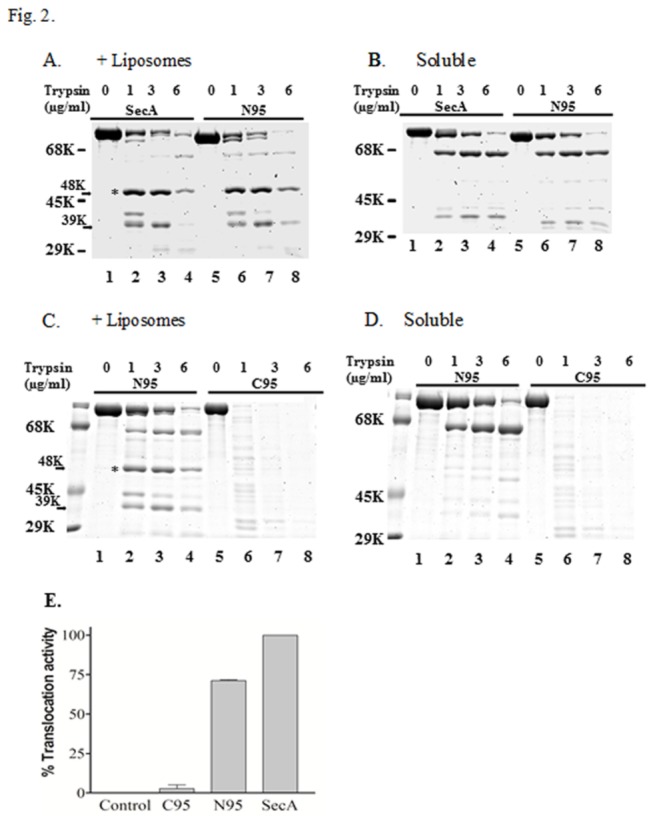
The importance of N-terminal, but not C-terminal, SecA for M48 formation and protein trnslocation.(A) Proteolysis of SecA and the N95 construct was carried out in the presence of EM (as described in the Materials and Methods) with the indicated concentration of trypsin. (B) Proteolysis of soluble SecA and the N95 construct was carried out (as defined in panel A) at the indicated concentration of trypsin (C) Proteolysis of EM-associated N95 construct and C95 were carried out (as defined in panel A) with the indicated concentration of trypsin (D) Proteolysis of soluble N95 and C95 constructs was carried out (as defined in panel A) with the indicated concentration of trypsin. (E) Translocation of pOmpA in the liposomes.